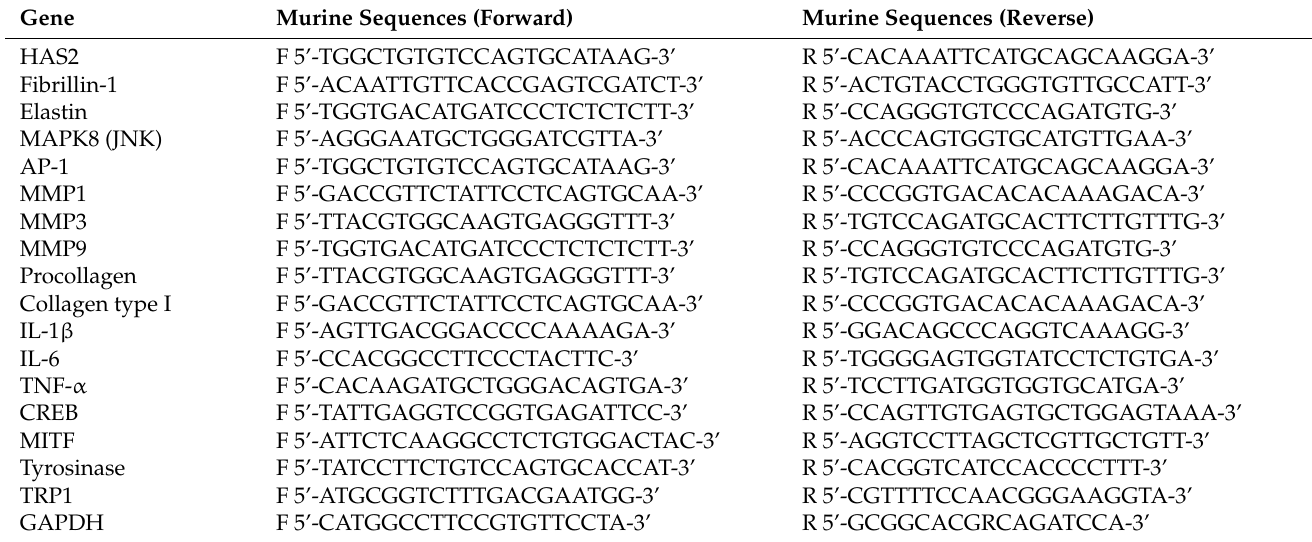
Table 1. Primer sequences used in real-time PCR-based quantification of